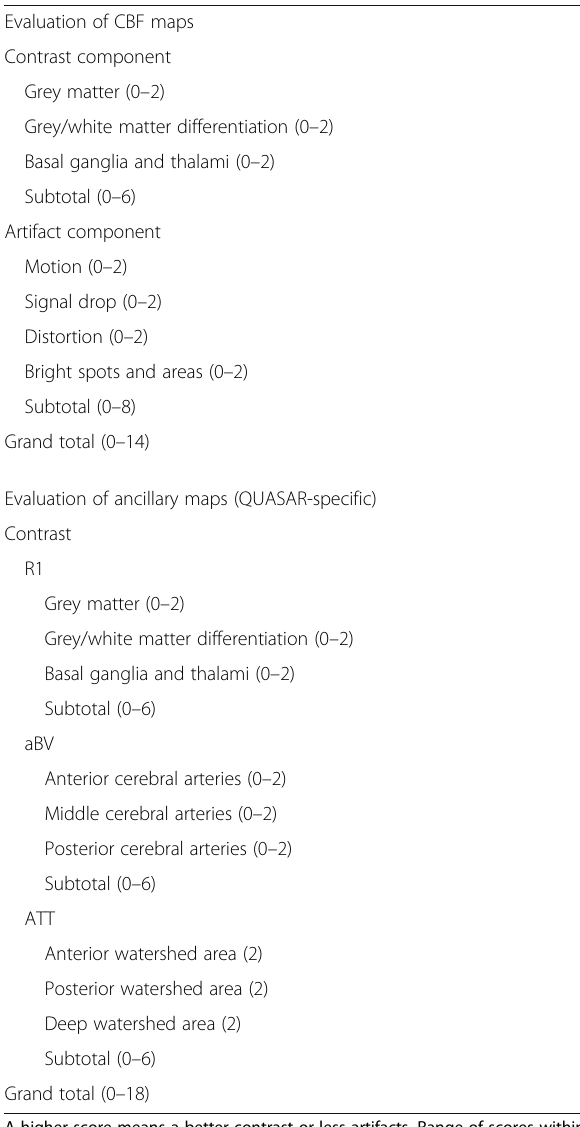
Table 1 Items evaluated for the visual quality control of ASL